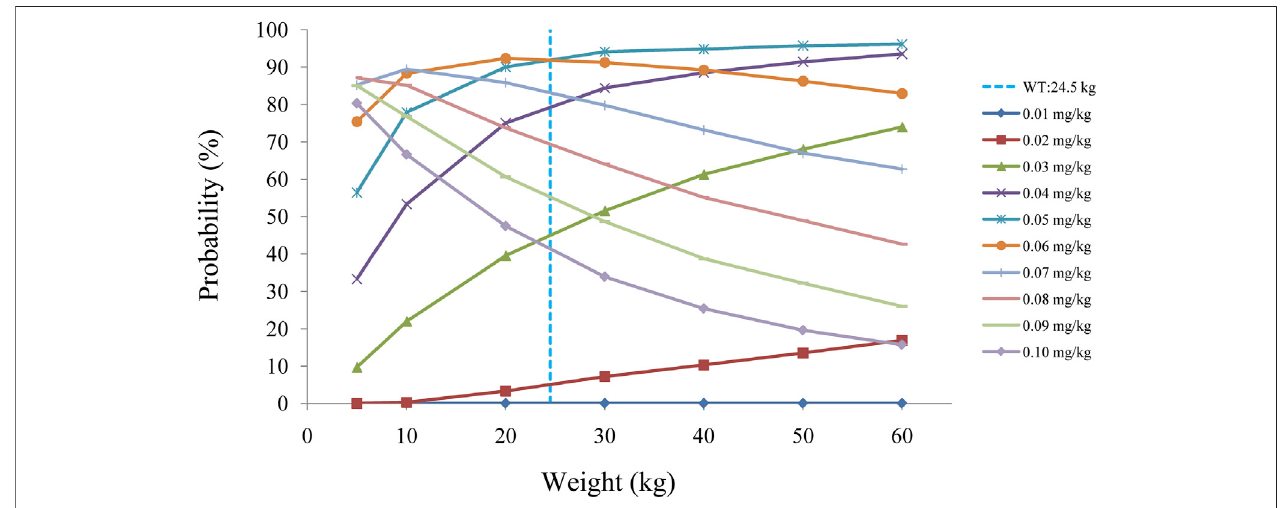
FIGURE 4 | Probability to achieve the target concentrations.